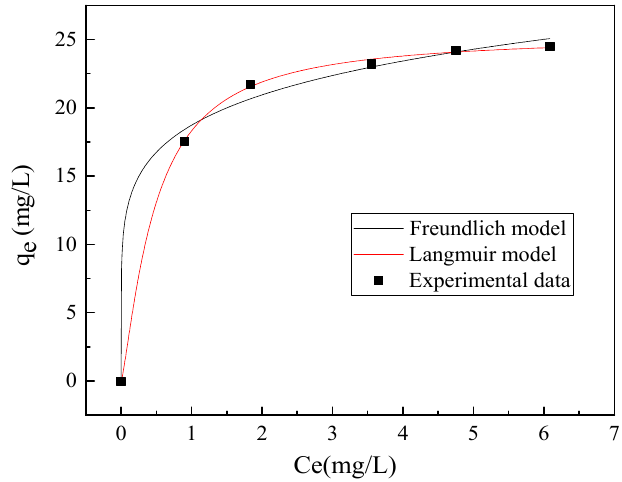
Figure 3. Isotherm for adsorption of chloride on CaAl-Cl LDH precursors.